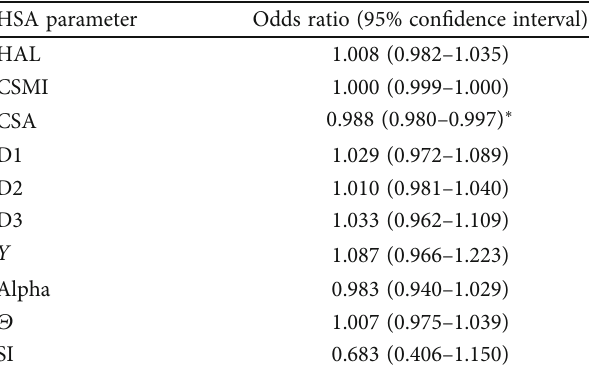
Table 3: Odds ratios of fracture for di ff erent HSA parameters. HSA